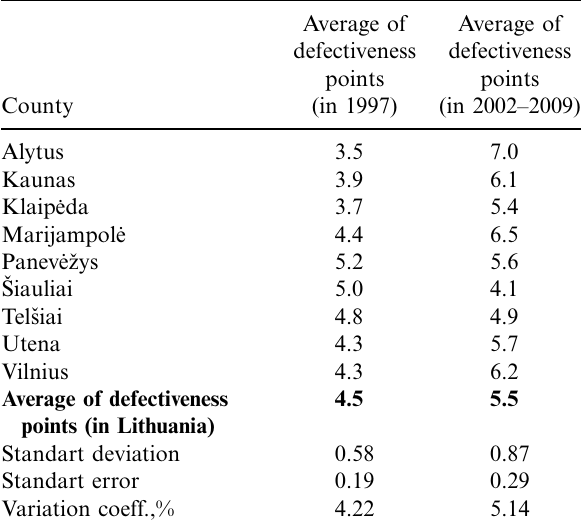
Table 2. Results of statistical analysis of technical state of investigated earth dams in